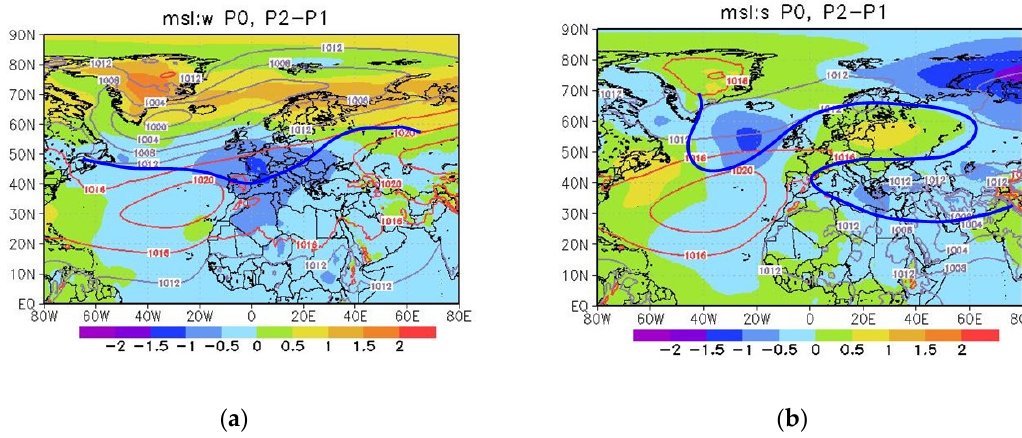
Figure 9. Mean sea level pressure difference (P2–P1) (shade) for winter ( a ) and summer ( b ). Isolines show the 40-year mean MSLP; the blue thick line is the zero line of the 300 hPa wind anomaly (P2–P1) from Figure 8.